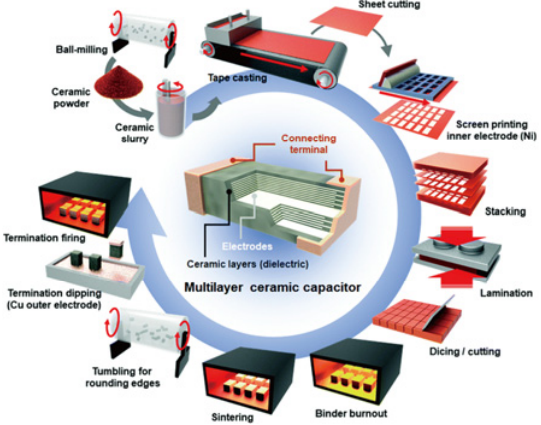
Fig. 23 Schematic diagram of MLCC preparation process. Reproduced with permission from Ref. [187], © IEEE 2010.